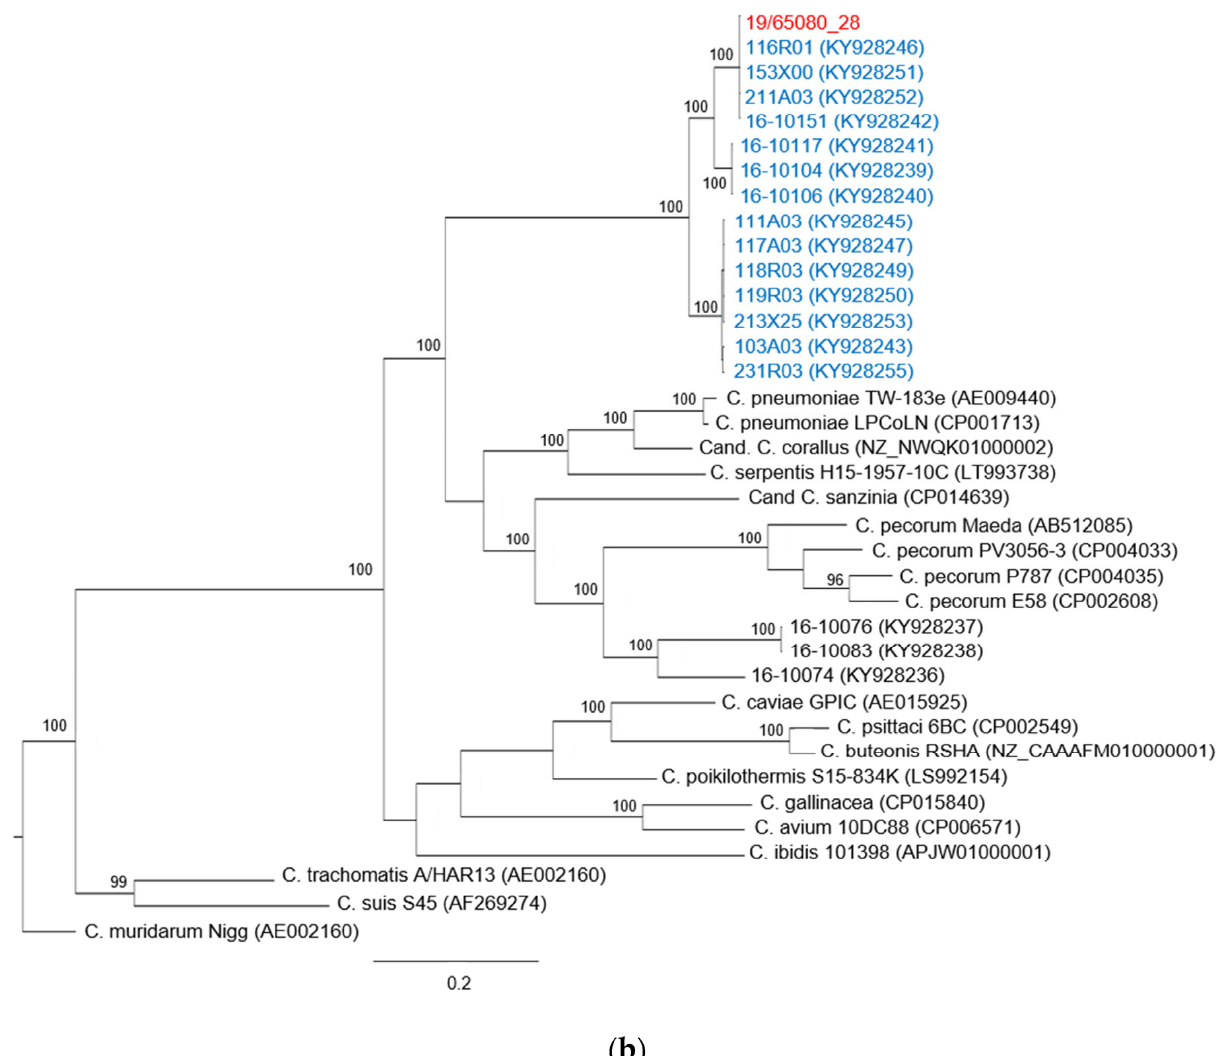
Figure 1. Phylogenetic trees based on ( a ) 16S rRNA gene fragment (920 bp) and ( b ) ompA gene (1200 bp). Representative sequences of Chlamydiaceae species as well as strains found in reptilian hosts were included and colored in black. The sequences identified in this study are shown in red, and sequences from Mitura et al. [27] are highlighted in blue. Chlamydia muridarum strain Nigg was used as outgroup. The phylogenetic tree was constructed with the MrBayes method, the GTR substitution model was applied for 16S rRNA gene, and the HKY85 model was applied to the ompA gene. Posterior probability values are shown as percentages, values under 95 were considered not reliable and are not shown. The scale bar indicates the number of substitutions per